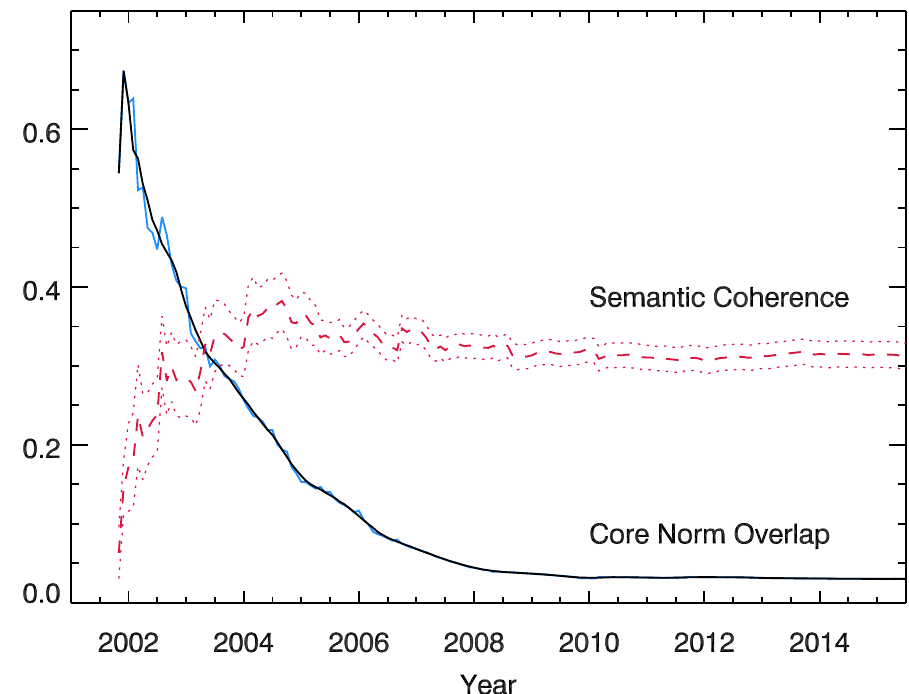
Figure 3. Evolution of influence overlap among the core norms (top twenty norms by eigenvector centrality) over time (solid line, labeled). In terms of the pages they influence, core norms draw apart over time, stabilizing in 2008. At the same time, semantic coherence (dashed line, labeled) increases. Neighborhoods become topologically distinct, but internally